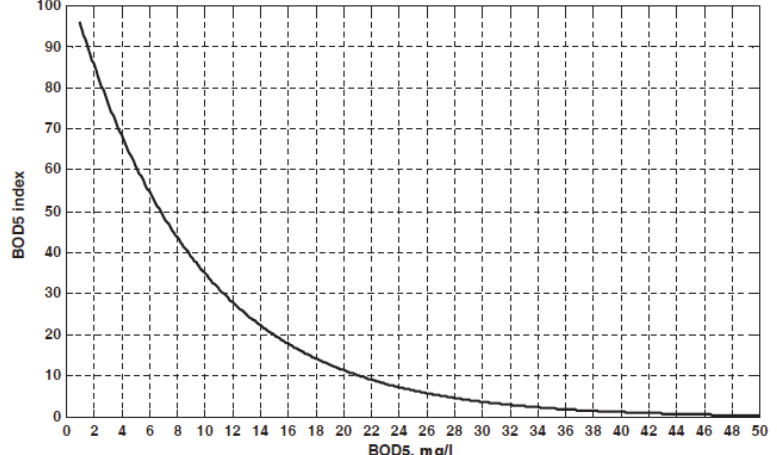
Fig. 3. BOD5 (The value of equivalent index is considered 1 for BOD5 more than 50)